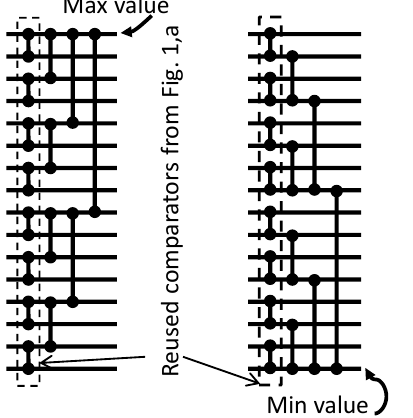
Fig. 6. Discovering the maximum/minimum values in the registers of Fig.